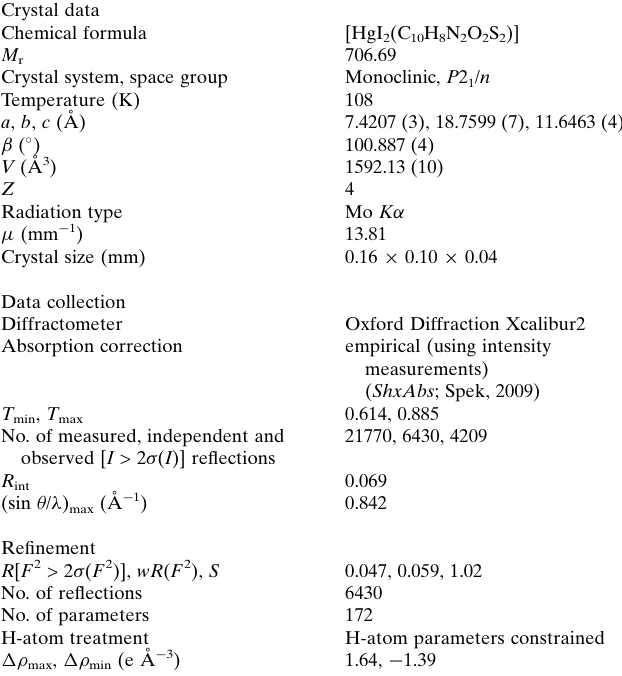
Table 2 Experimental